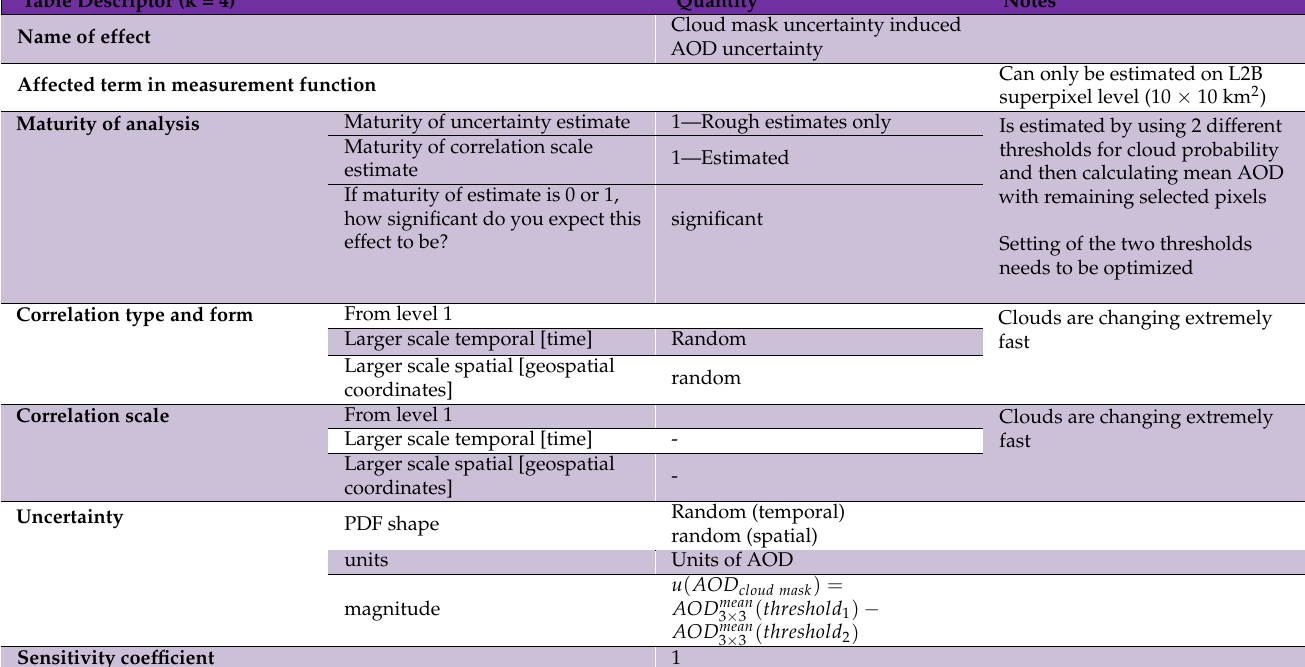
Table 4. Effects table for cloud-mask induced uncertainty. Table Descriptor (k =